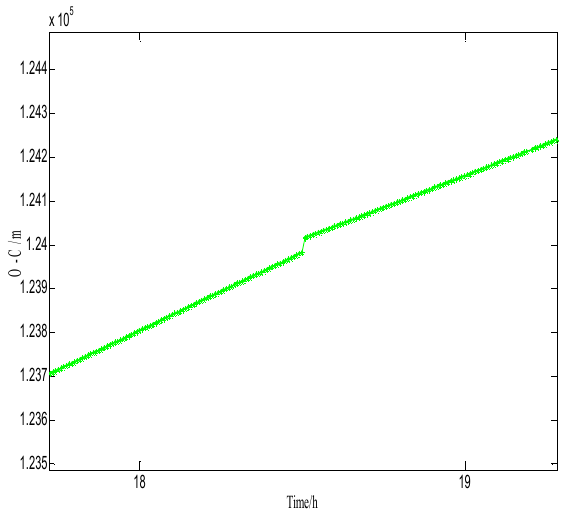
Figure 13. Results of O-C of GEO-01 at BJF1.